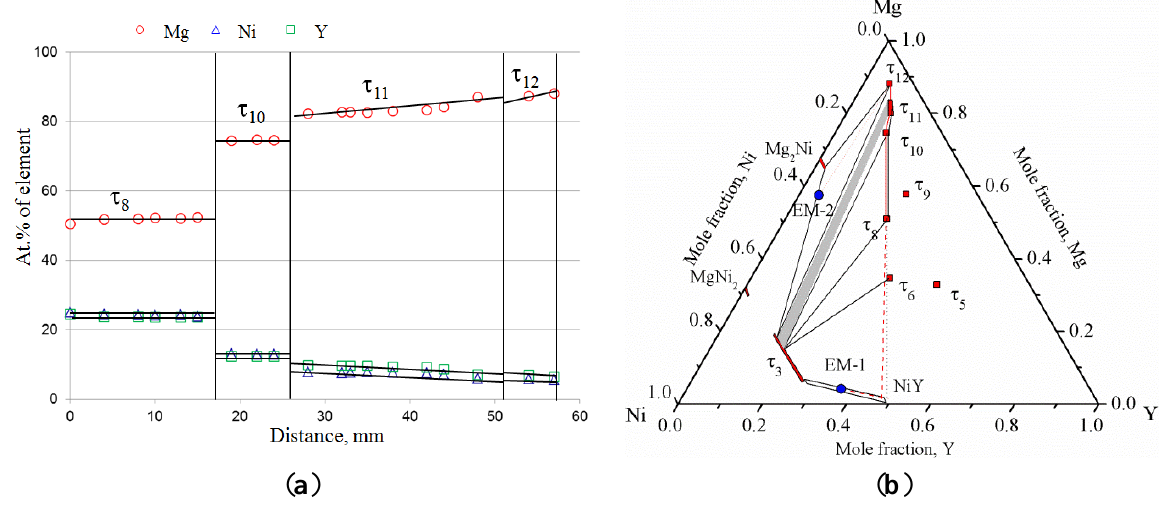
Figure 6. ( a ) Composition profile of the diffusion couple 2 along the line scan shown in Figure 5; ( b ) Extracted phase equilibria based on the solid-solid diffusion couple 2 projected on the Mg-Ni-Y Gibbs triangle. Dotted line indicates expected phase equilibria which is not recognized in DC 2.